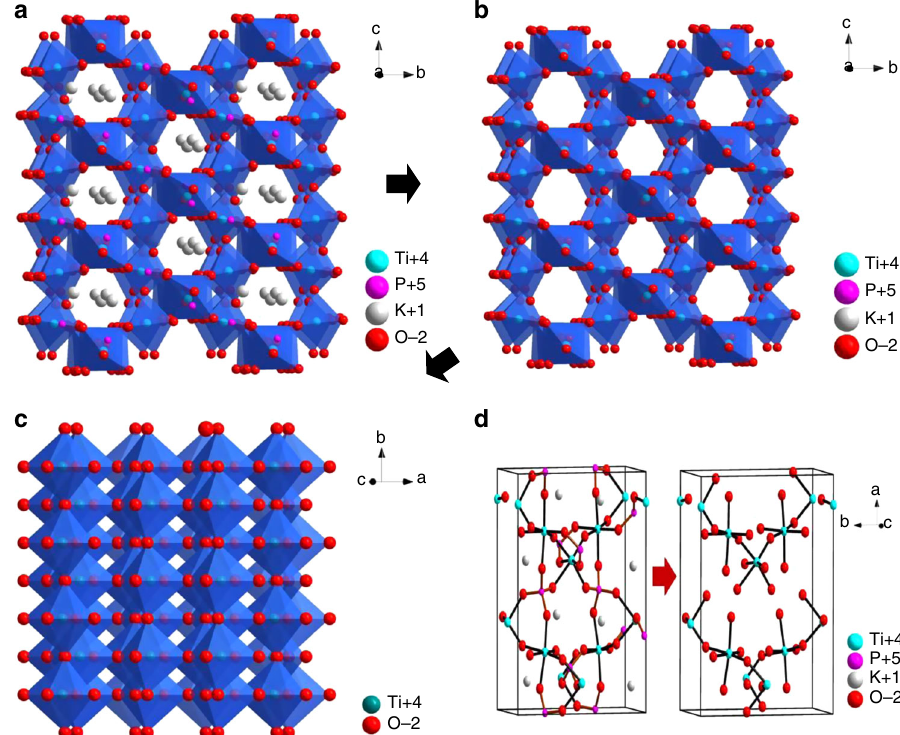
Fig. 4 Crystal structure and lattice channel of K/P removal in KTP crystals. a K/P evaporation channels in a-axis KTP (view along a-axis). b Framework of TiO 2 by removing the K and P from the KTP (view along a -axis). c Crystal structure of anatase TiO 2 (view along 101 axis). d Ball and stick model of the transformation of KTP to TiO 2 (view toward 101